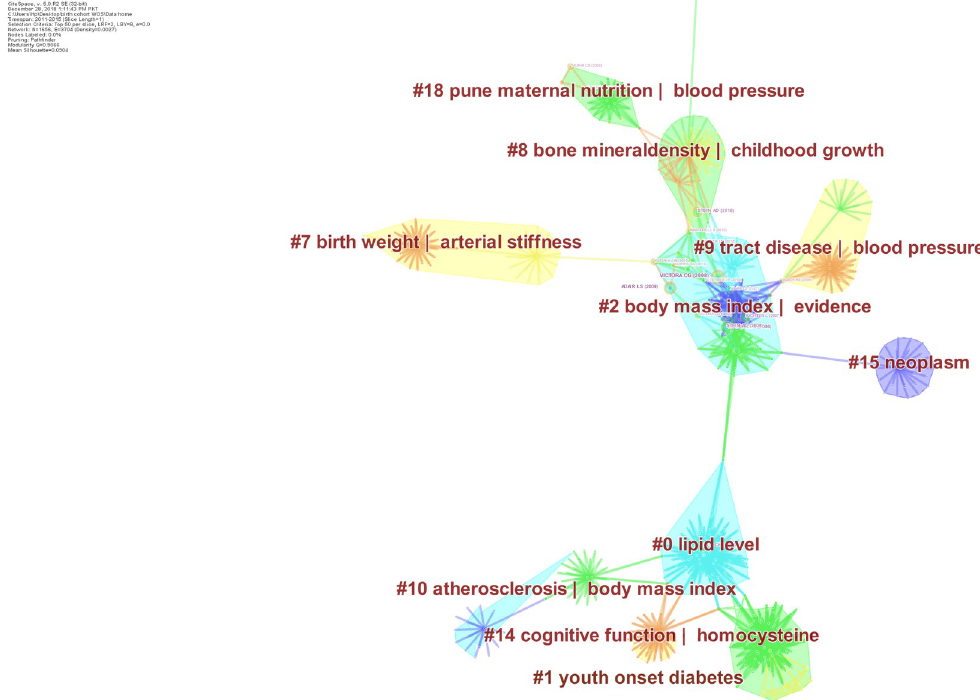
Fig 7. Research foci from 2011-2015a. This figure depicts major themes and foci of research output stemming from different birth cohorts established in South Asian Region, from 2011 to 2015. The shaded regions represent different clusters of research, labelled using indexed keywords. For instance, cluster # 0 is labelled as lipid levels . Several nodes depicting number of citations as tree rings are shown to represent important entities. Purple coloured nodes represent landmark works that connect two clusters. Edges presenting relationship between two nodes are presented as lines. Different clusters are depicted with different